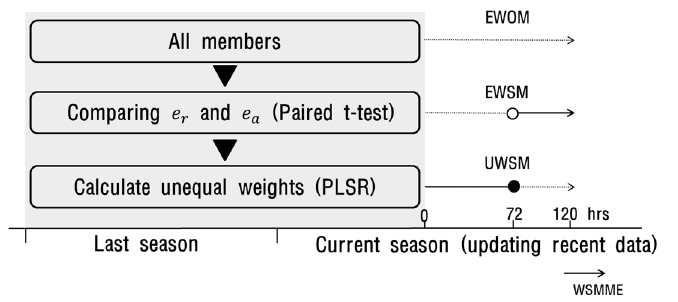
Figure 2. The schematic plot for three Multi-Model Ensemble (MME) tests and Weighted Selective MME (WSMME). WSMME forecasts are the solid lines of Equally Weighting Selective MME (EWSM) and Unequally Weighting Selective MME (UWSM).